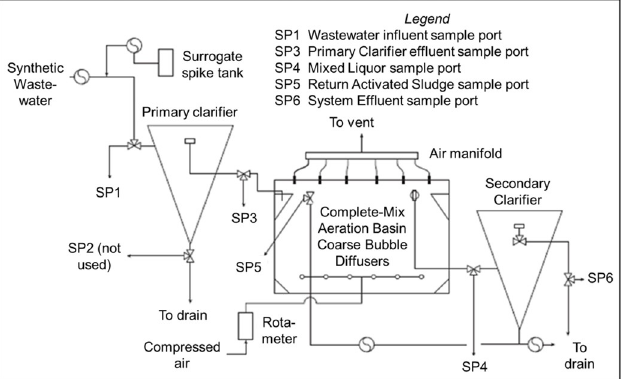
Fig 2. Schematic diagram of the pilot-scale AST system. Note that sample port 2 (SP2) is not used for this study.